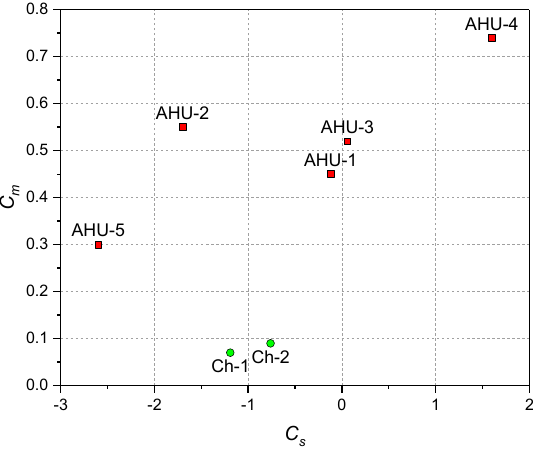
Figure 4. Values of C m versus C s for five AHUs and two chillers.